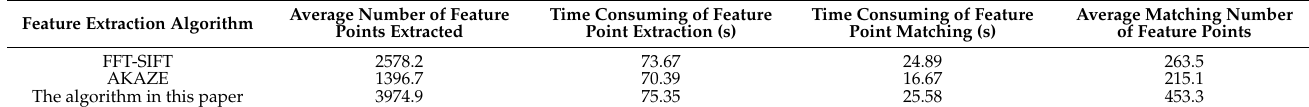
Table 3. Comparison of different algorithms in the printing process.